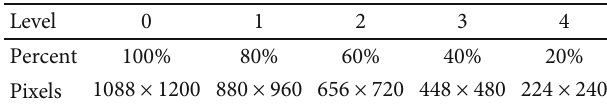
Table 1: Resolution